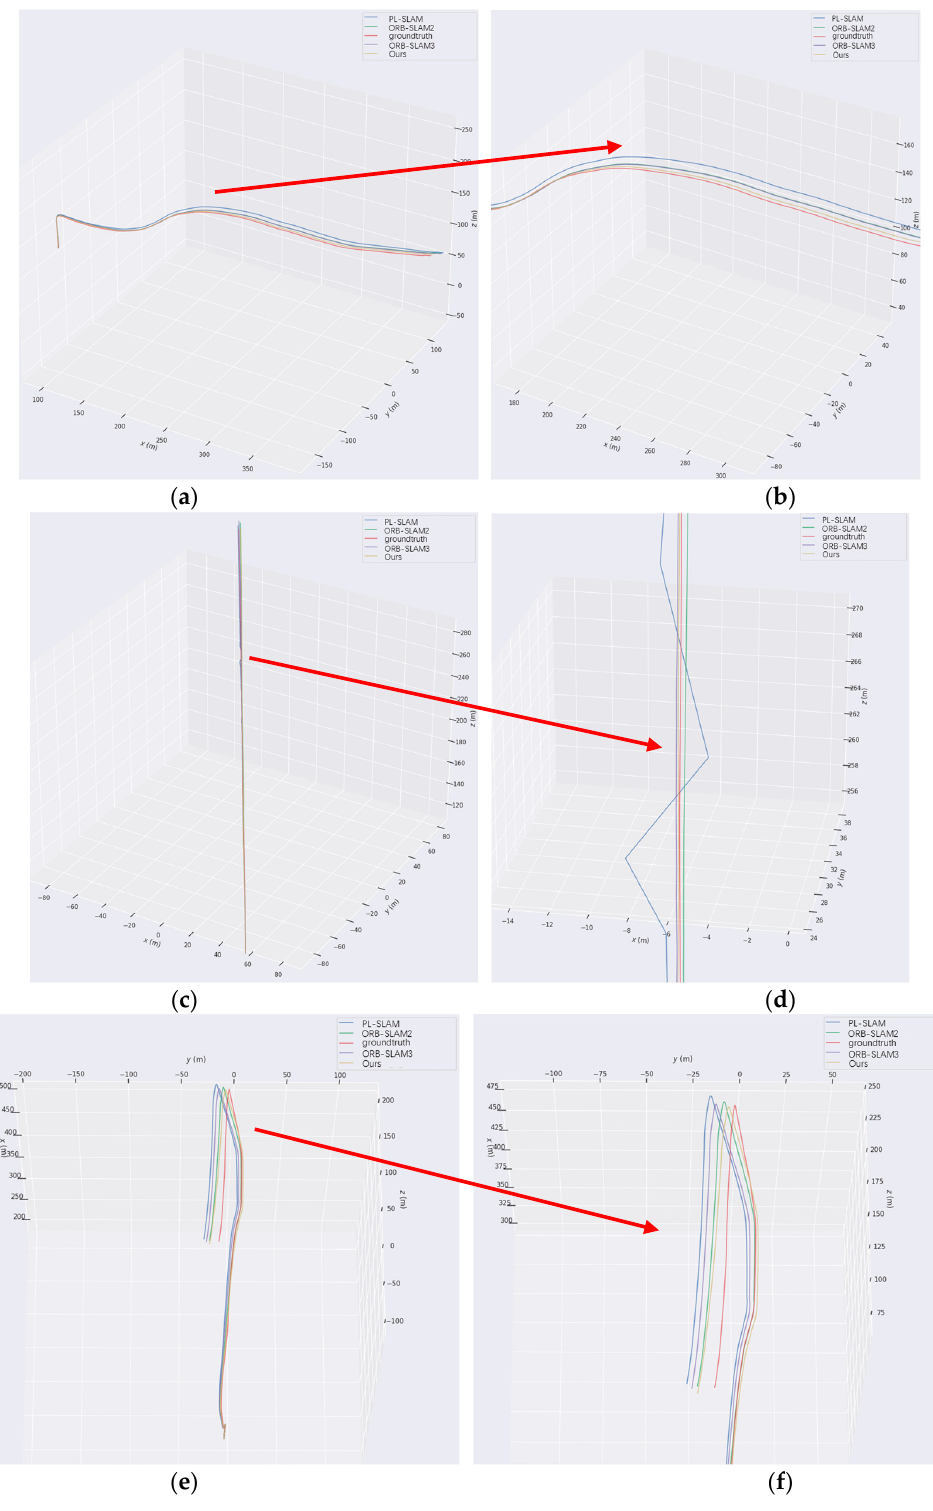
Figure 9. A comparative experiment is carried out on the KITTI dynamic data set, where the red line is the real value, the light yellow line is our proposed method, the green line is the ORB-SLAM2 method, the blue line is the PL-SLAM method, and the light blue line is the ORB-SLAM3 method. ( a , b ) are space estimation comparisons in the KITTI dataset sequence 03. ( c , d ) are spatial estimation comparisons in the KITTI dataset sequence 04. ( e , f ) are spatial estimations in the KITTI dataset sequence 10. Among them, ( a , c , e ) are spatial contrast, ( b , d , f ) are the comparison of